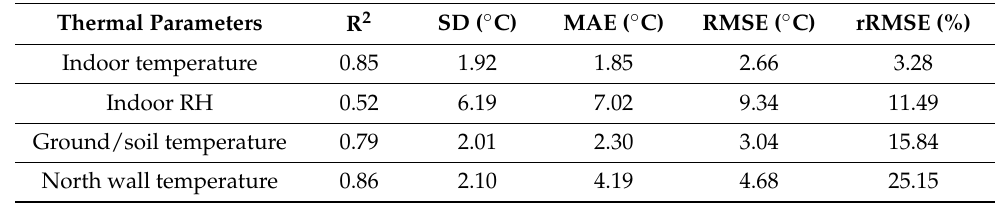
Table 2. Statistical indices for evaluating the model performance for various thermal parameters of the